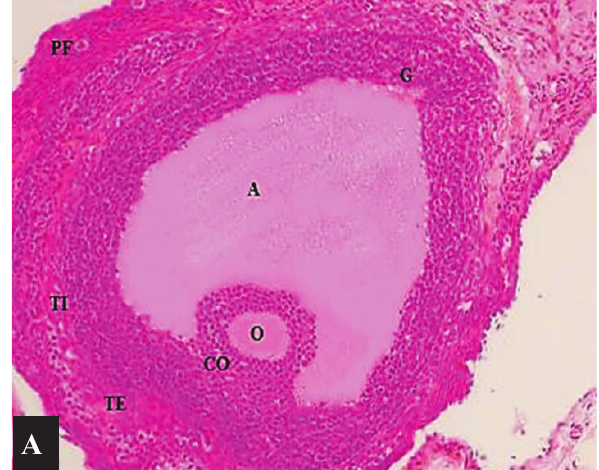
Fig-4D: Graafian follicle of rat experimental group D showing normal structure, Antrum (A), Ovum (O), Zona Granulosa (G), Theca Interna (TI), Theca Externa (TE). (H & E at 20x) Group